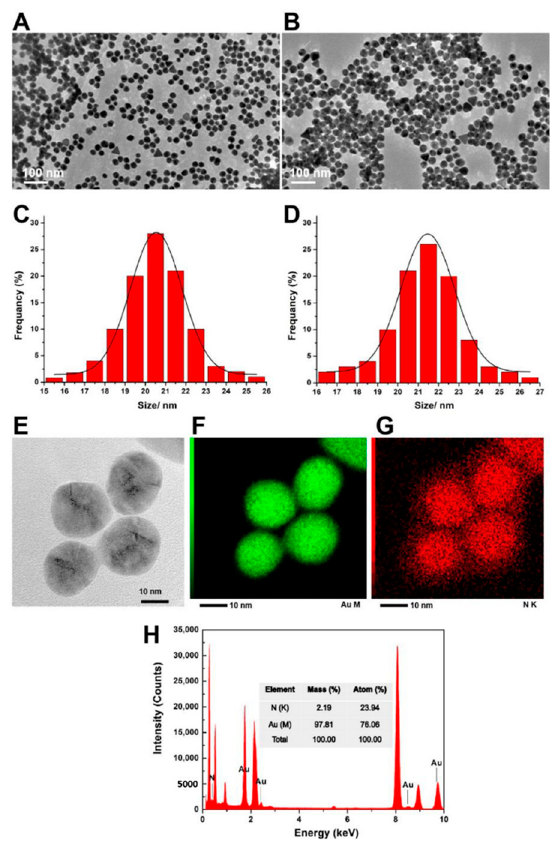
Figure 1. The TEM images for gold nanoparticles (AuNPs) ( A ) and AuNPs-poly (N- isopropylacrylamide) (PNIPAM) ( B ), and size distribution for AuNPs ( C ) and AuNPs-PNIPAM ( D ). High magnification TEM image for Au-PNIPAM ( E ). TEM EDS mapping images for the Au element ( F ) and N element ( G ) and corresponding spectrum ( H